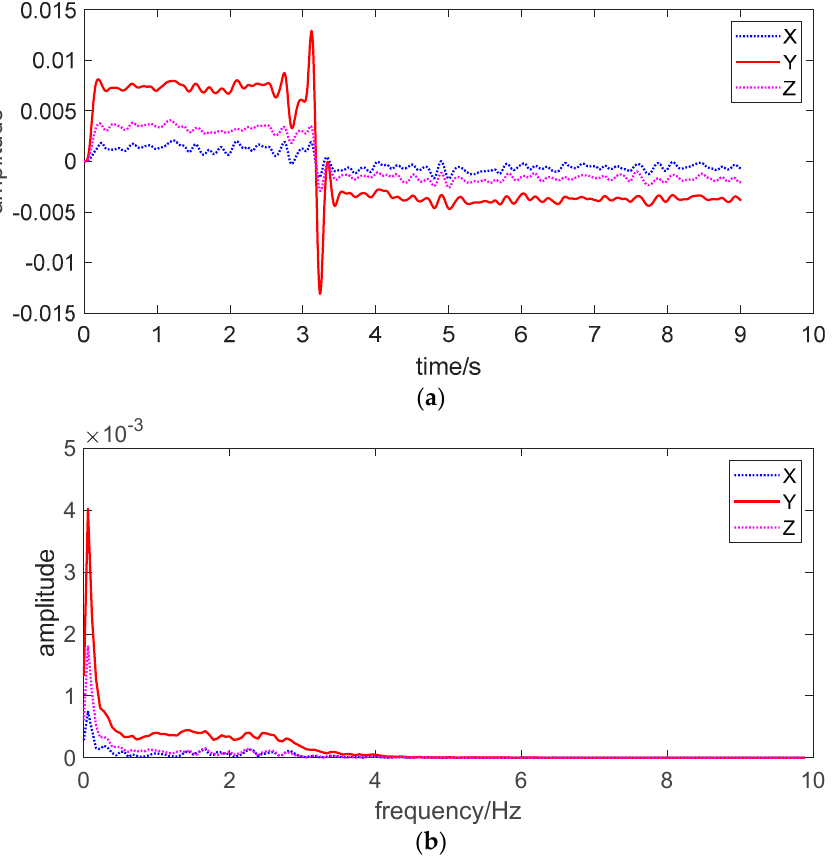
Figure 12. The monitoring results of sand interface slide in the experiment. ( a ) Time history of the recorded signals ( b ) Spectra of the recorded signals.